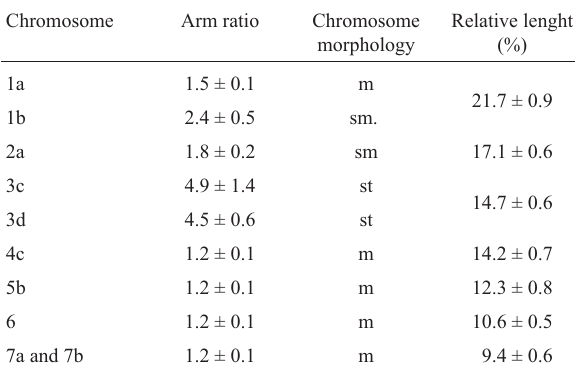
Table 3 - Karyometric data of triploid specimens of Dolichoplana carvalhoi (2n = 3x = 21 chromosomes) obtained after measurements of 14 conventionally stained mitotic